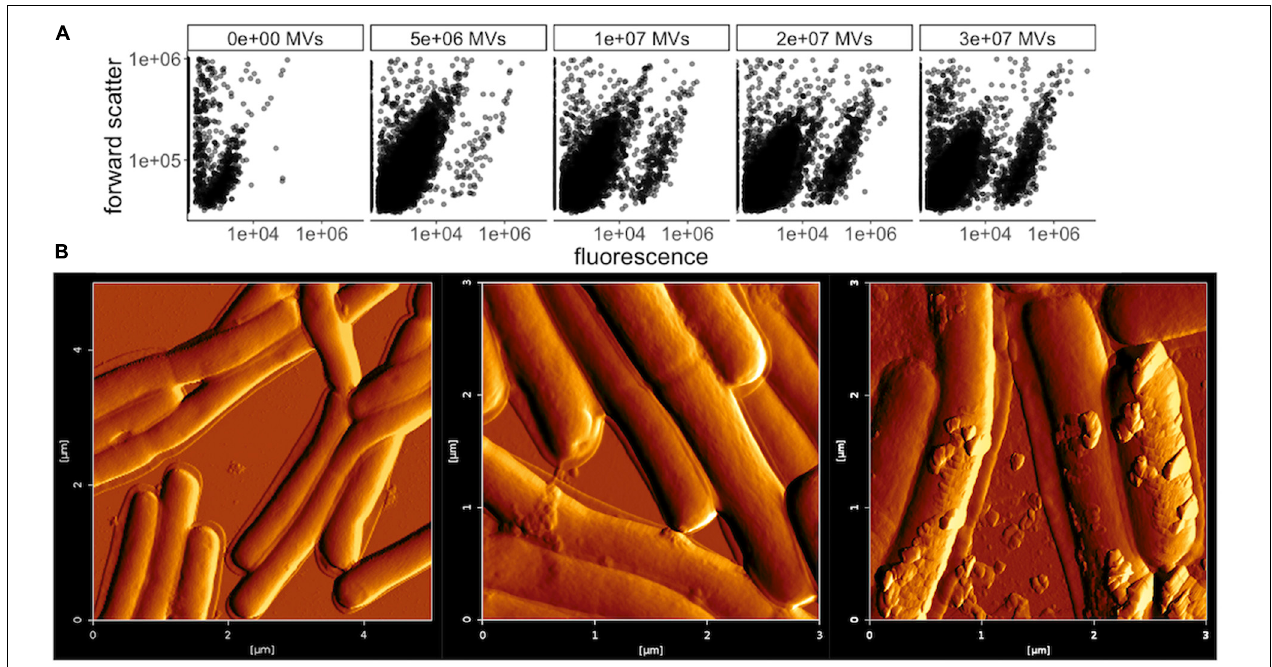
FIGURE 9 | Membrane fusion of MVs with L. delbrueckii . (A) Flow cytometry plots of forward scatter over FL1 fluorescence (533/30 nm) showing L. delbrueckii incubated with increasing amounts of DiO-labeled MVs purified from LabIP-induced L. acidophilus cultures. (B) Atomic force microscopy (AFM) images of L. delbrueckii incubated with increasing amounts (from left to right: no MVs, 4 × 10 6 or 8 × 10 6 ) of MVs purified from LabIP-induced L. acidophilus